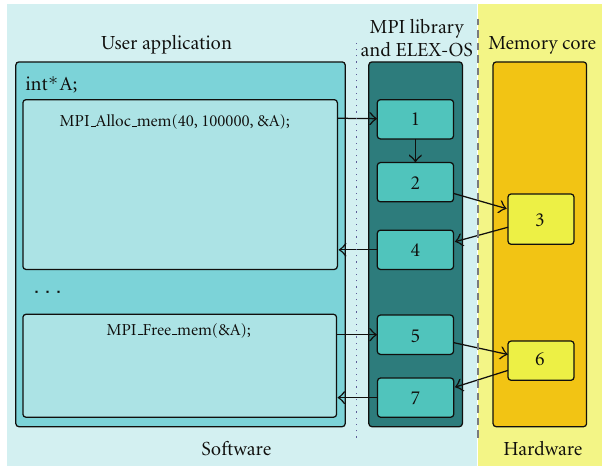
Figure 7: Application flow for allocating and releasing external memory with the memory core using MPI.